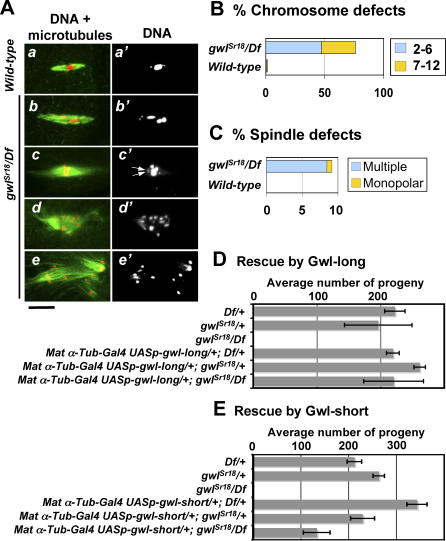
Gwl Is Required for Female Meiosis(A) Examples of meiotic defects observed in gwlSr18/Df oocytes. Alpha-tubulin is stained green and DNA is red. Note the small, probably nondisjoined Chromosomes 4 in b-b'. In c', arrows indicate likely separated sister chromatids of the fourth chromosome. A typical wild-type (Oregon R) meiotic figure arrested in metaphase I is shown for comparison (a). The longer spindles in b and c are a typical feature of the bipolar spindles formed in gwlSr18/Df oocytes. Scale bar is 10 μm.(B) Quantitation of chromosomal defects observed in metaphase and anaphase oocytes. In wild-type oocytes, only 2% appear to have progressed into a normal anaphase (not included in this quantitation). Chromosome defects were characterized by scattered chromosome masses. The number of DNA masses, excluding the tiny fourth chromosome, was counted in defective figures. The percentage of defective figures presenting two to six DNA masses (as in Ab–c) or seven to 12 DNA masses (as in Ad–e) is shown. Normal figures showed either one mass in metaphase or two masses in anaphase.(C) Quantitation of spindle defects observed in metaphase and anaphase oocytes. Defective, multipolar, and occasionally monopolar spindles are observed in gwlSr18/Df oocytes (as in Ad–e). 149 Oregon R oocytes and 142 gwlSr18/Df oocytes were scored in these experiments (B and C).(D and E) Rescue of gwlSr18/Df female fertility with the expression of UASp-gwl-long (D) or UASp-gwl-short (E) driven from the Mat α-Tub-Gal4 driver (in two separate experiments). The average numbers of adult progeny per female from 6 d (D) or 7 d (E) of egg laying by females of the indicated genotypes are shown (± standard error of the mean). See Text S1 for details. Females of the genotypes used in (E) were also tested for meiotic chromosome nondisjunction by crossing to YSX.YL, v f B/0; C(4)RM, ci eyR/0 males. Numbers of (nullo-4, diplo-X+nullo-X)/total progeny are, from top to bottom: (0, 0)/432; (2, 0)/671; no progeny; (0, 0)/646; (0, 0)/397; and (2, 0)/294.